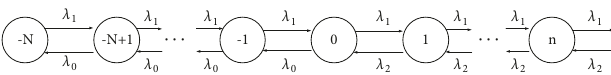
Figure 1: State transition diagram for the passenger-taxi service system.